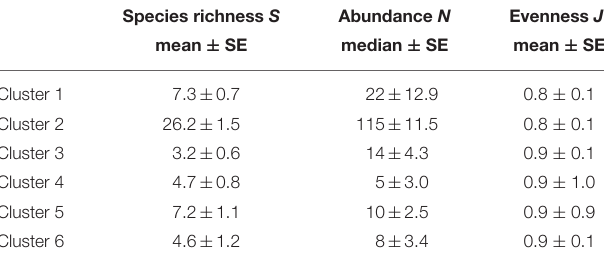
UKTAG v.1: update 11/03/2014, which is freely available from the WDF UKTAG webpage.